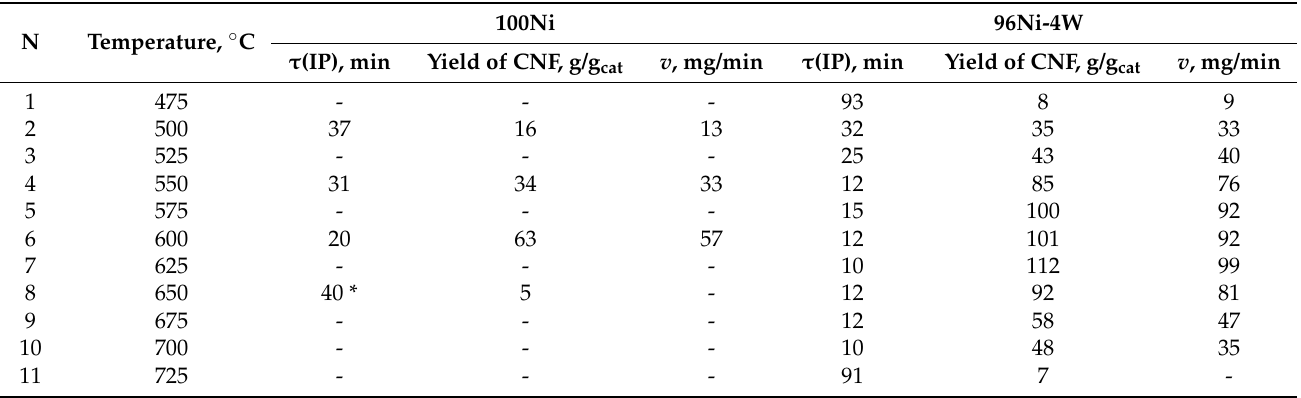
Table 1. Catalytic decomposition of TCE over 100Ni and 96Ni-4W samples within the temperature range of 450–650 ◦